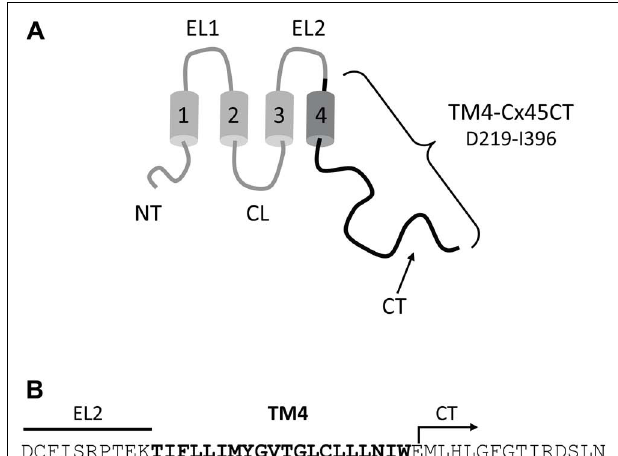
FIGURE 1 | Model of theTM4-Cx45CT construct. (A) Schematic diagram of full length Cx45.The black coloring represents theTM4-Cx45CT construct. (B) The amino acid sequence of theTM4-Cx45CT (D219-I396) contains a portion of the EL2 (line) and the entireTM4 (bold) and CT (arrow)